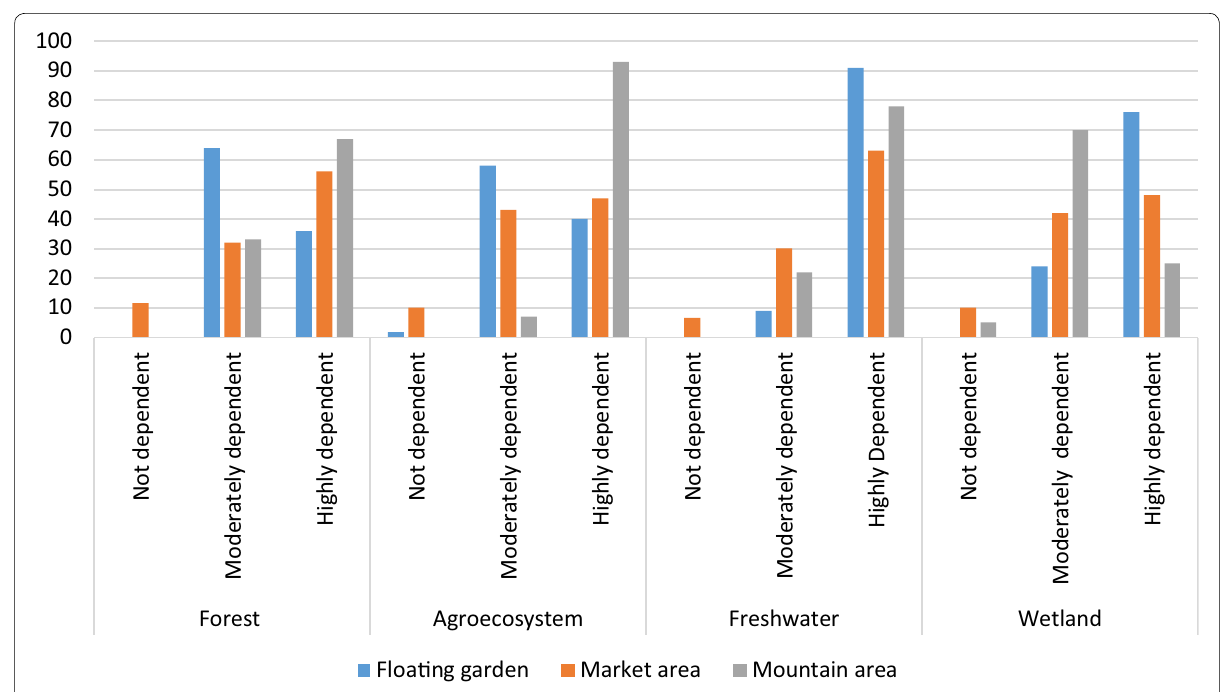
Fig. 4 Figure showing dependency of people in different ecosystems across the study sites